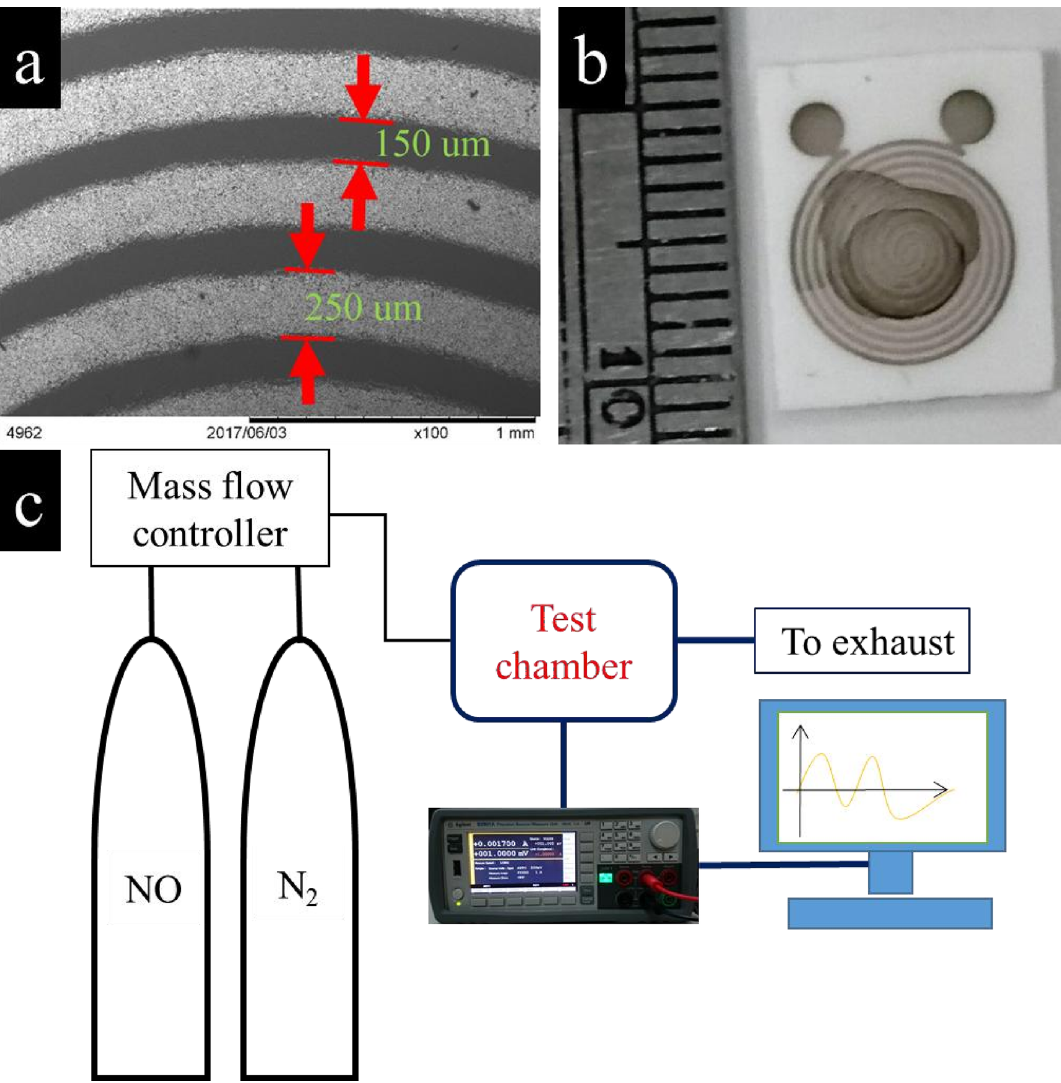
Figure 1. ( a , b ) Microelectrodes with an interdigital structure consisting of Ag–Pd conducting paths on an Al 2 O 3 substrate. ( c ) Schematic of